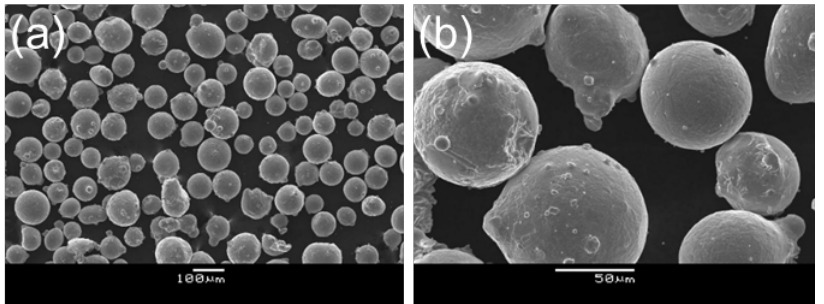
Figure 1. Morphology of NiCrAlY alloy powder: ( a ) 100×; ( b ) 500×.